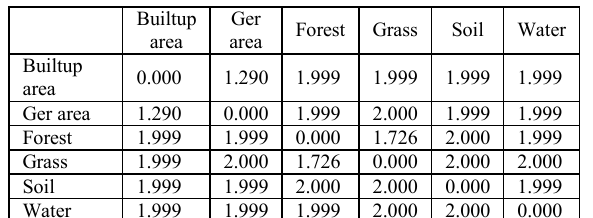
Figure 2. Comparison of the images obtained by the selected feature combinations: (a) the image obtained by Landsat band combinations (R=B5, G= B4, B= B3); (b) the image obtained by selected Landsat band combinations (R= B4, G= B5, B= B6); (c) the image obtained by optical and SAR features (R= B3, G= B5, B=SAR); (d) PC image (R=PC1, G=PC2, B=PC3)